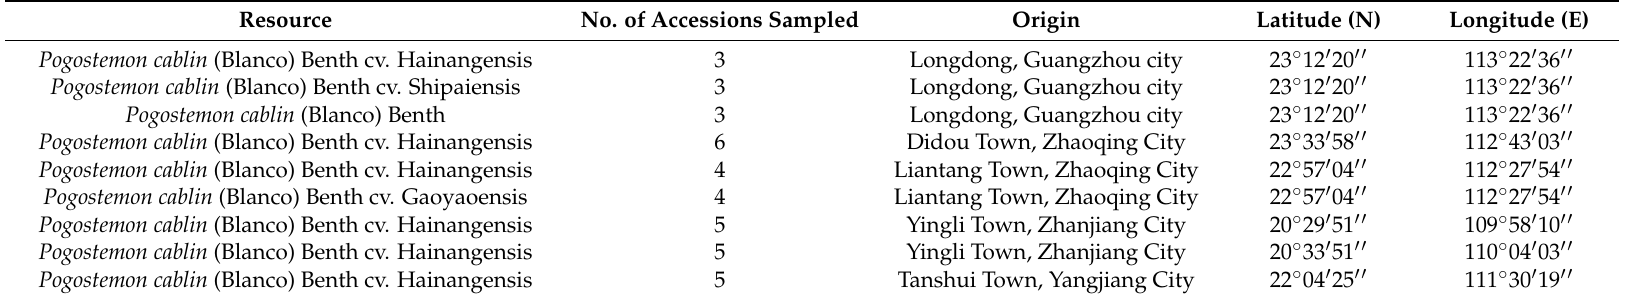
Table 3. List of 38 patchouli accessions used in the analysis of genetic diversity.